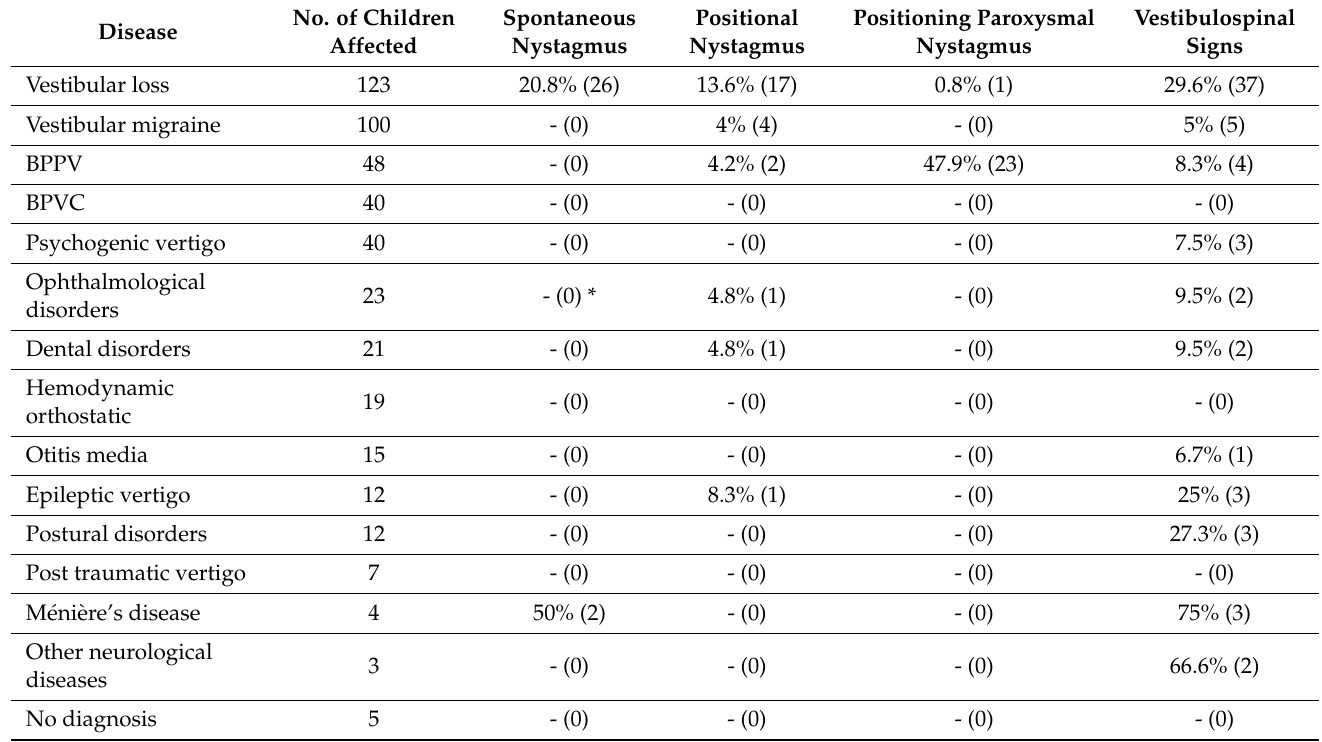
Table 3. Percentage of signs revealed by clinical examination according to cause of vertigo in children (No. of children with positive results is reported in parenthesis).